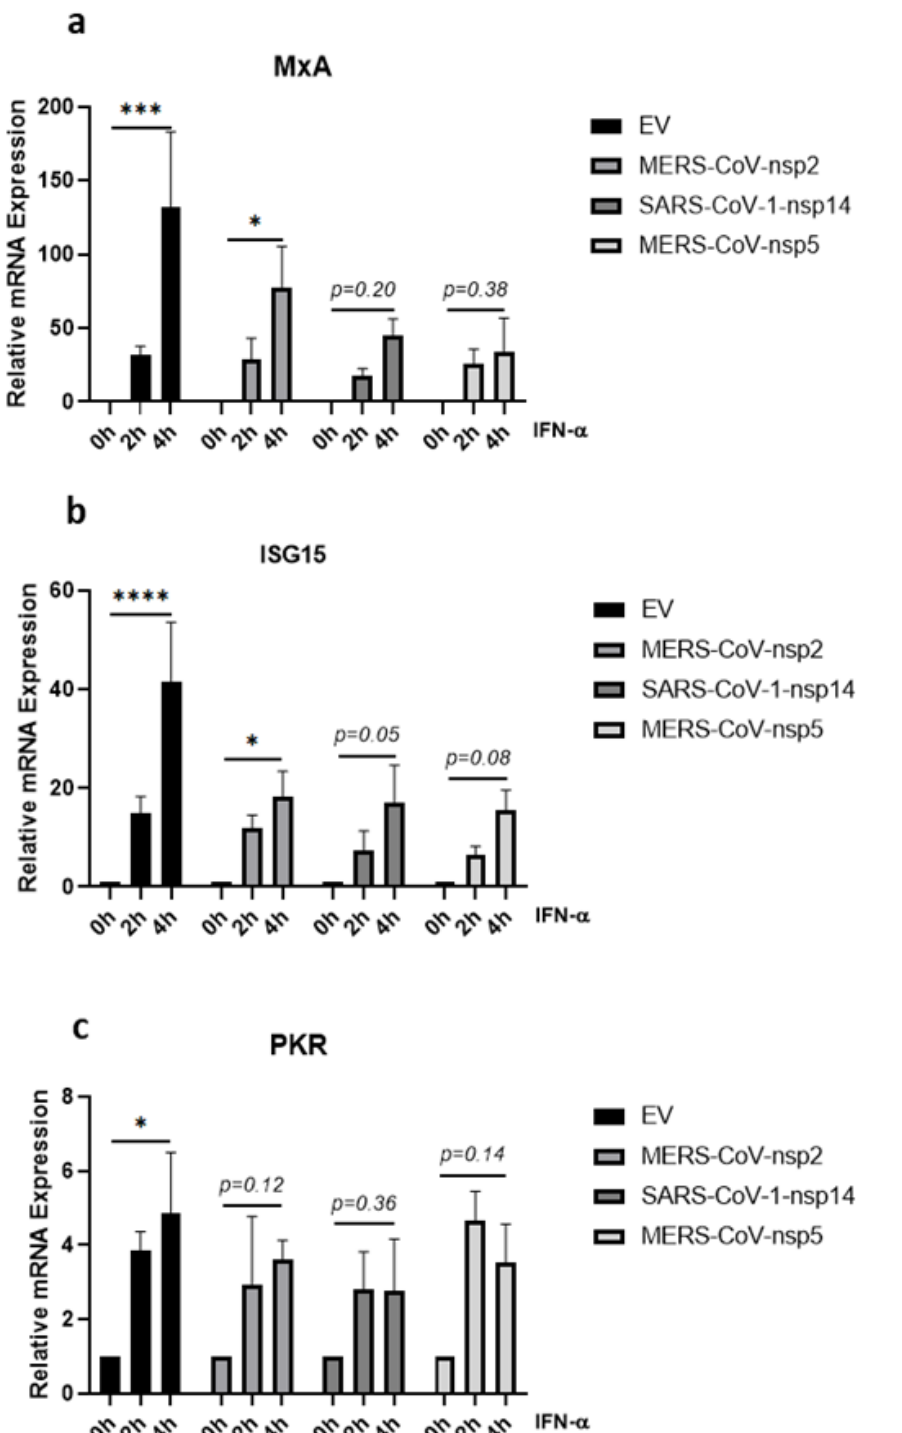
Figure 5. MERS-CoV-nsp2, SARS-CoV-1-nsp14, and MERS-CoV-nsp5 expression impair IFN- α - mediated ISG induction in BEAS-2B cells. BEAS-2B cells were transfected with Empty Vector (EV) or HA-tagged MERS-CoV-nsp2, SARS-CoV-1-nsp14, or MERS-CoV-nsp5. After 24 h, cells were treated with IFN- α (1000 U/mL) for 2 or 4 h before analysing: ( a ) MxA, ( b ) ISG15, and ( c ) PKR mRNA by qRT-PCR. Gene expression was normalised to house-keeping gene RPS15 and IFN- α treated samples were compared to the untreated control (IFN- α 0 h), which was normalised to 1. All graphs are the mean ± SEM of three independent experiments. * p < 0.05, *** p < 0.001, **** p < 0.0001 (Two-way ANOVA).